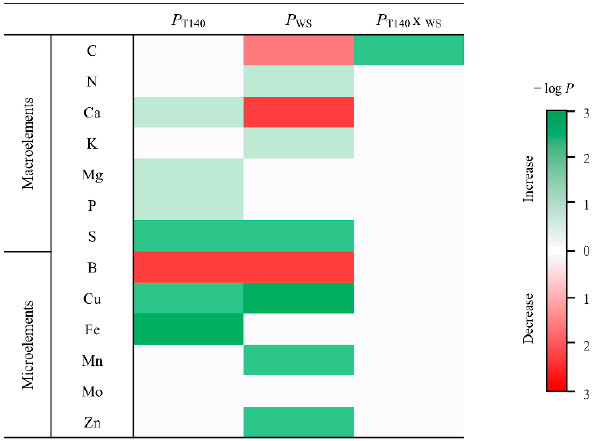
Figure 6. Effect of T140 application, water stress (WS, 1/2 watering applied), and the combination of both on the macro- and microelement contents of wheat grains harvested in the greenhouse assay 28 weeks after sowing. The heat map is colored according to the significance degree (–log p -value), with darker green indicating a higher increase and darker red indicating a greater decrease in the content. Data are calculated from five replicates per each treatment and irrigation condition ( n = 5). For each element, a significant effect was determined by a two-way